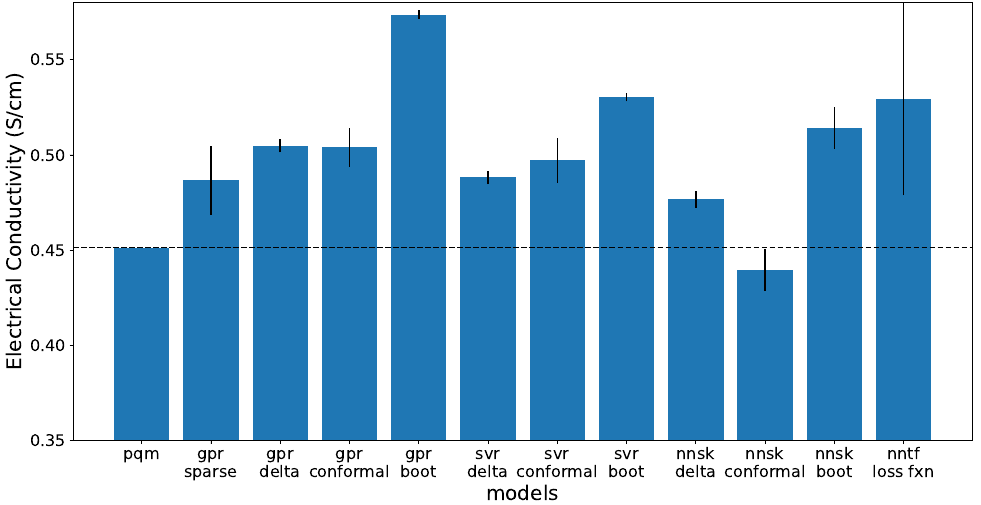
Figure 7. Electrical conductivity property results. During numerical optimization, the property was constrained between 0.59 S/cm and 0.12